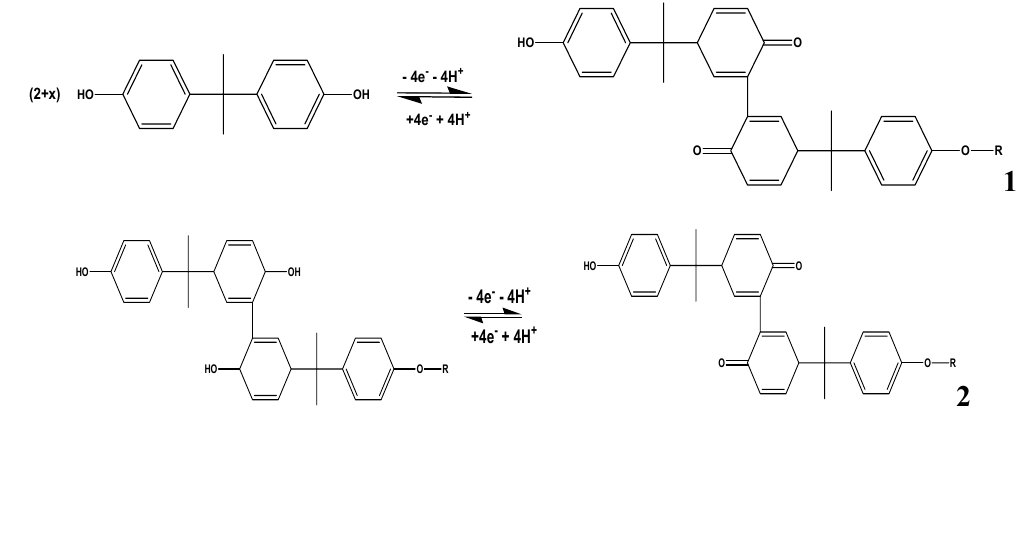
Scheme 1. Mechanism for BPA electro-oxidation on solid electrode